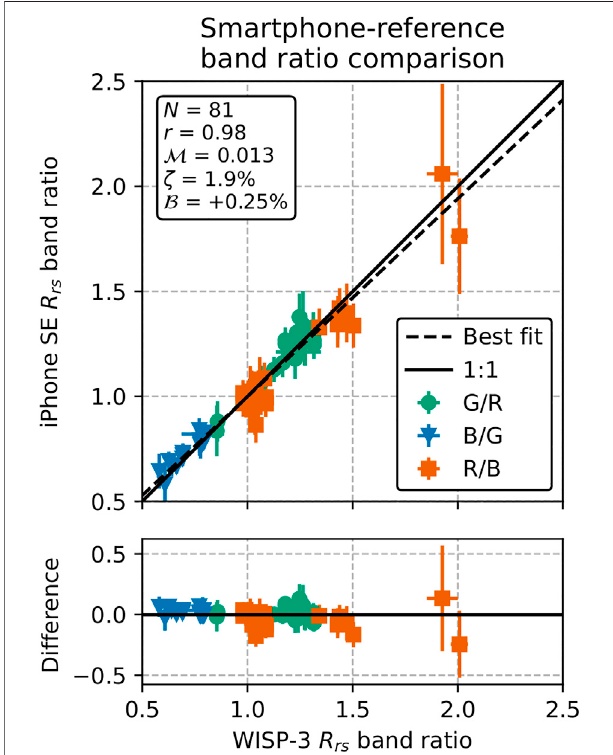
FIGURE 12 | Comparison between iPhone SE and spectrally convolved WISP-3 R rs band ratios. The solid line corresponds to a 1:1 relation, the dashedlineisthebest- fi ttinglinearregressionline.Thestatisticsinthetextbox arebasedona1:1comparison,asarethedifferencesinthelowerpanel.